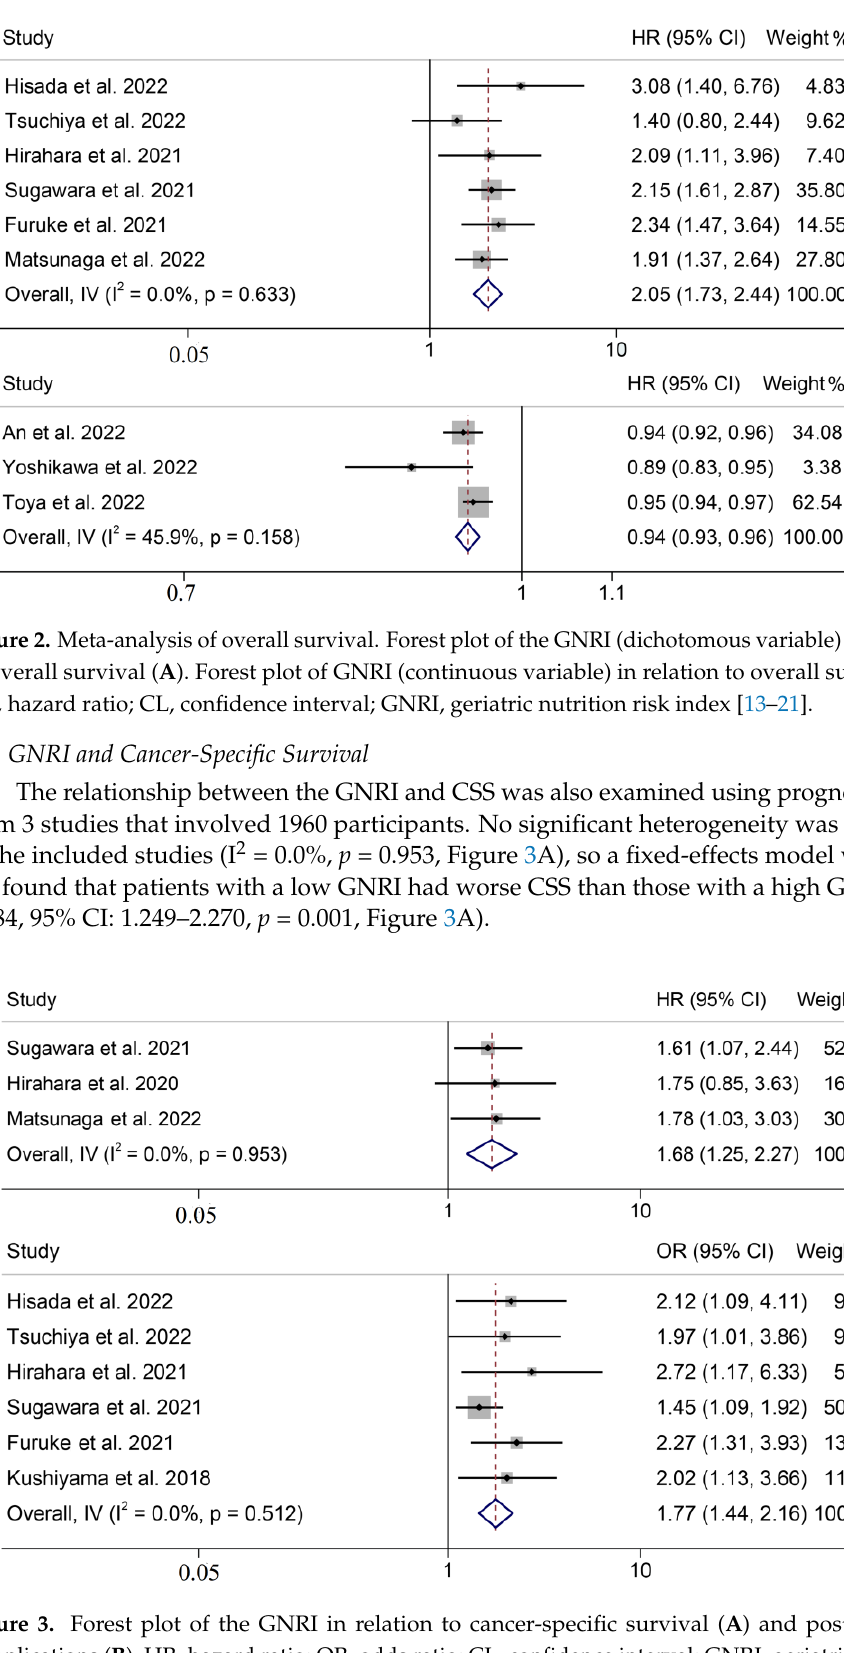
Figure 3. Forest plot of the GNRI in relation to cancer-specific survival ( A ) and postoperative com- plications ( B ). HR, hazard ratio; OR, odds ratio; CL, confidence interval; GNRI, geriatric nutrition risk index [14,16,17,19 –